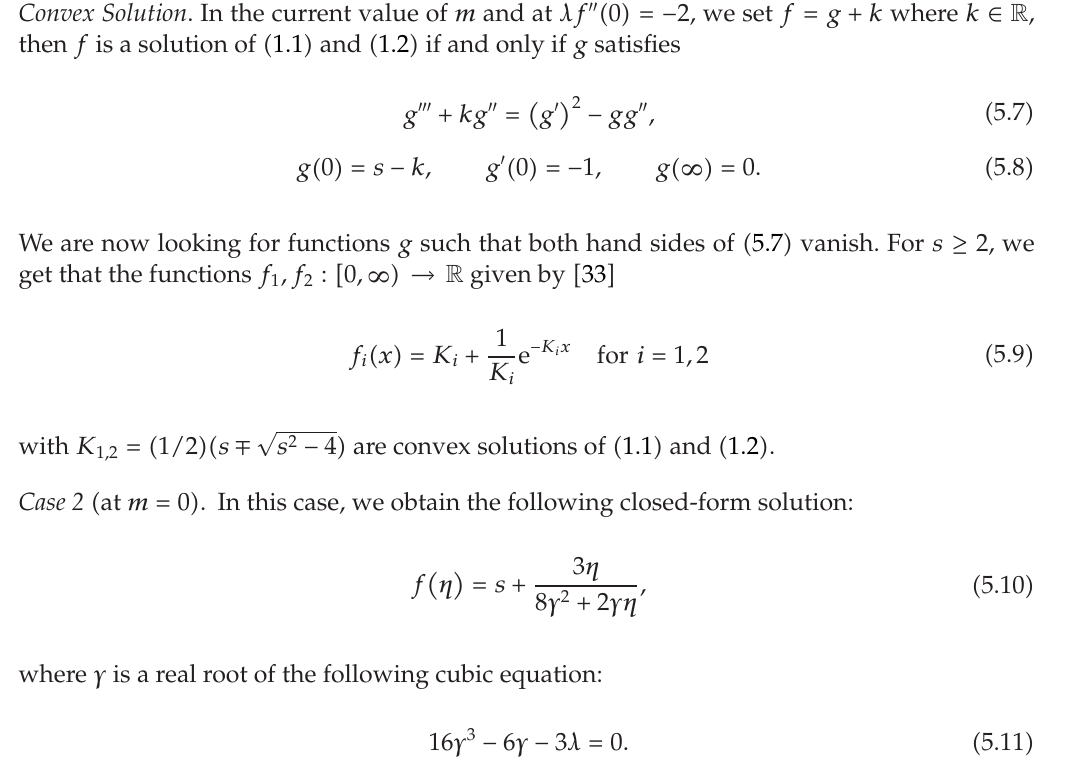
(cid:3) η, f (cid:3) η (cid:4)(cid:4) plane at m (cid:8) 1 for (cid:3) a (cid:4) s (cid:8) 1, λ (cid:8) 0 . 5 and (cid:3) b (cid:4) s (cid:8) 0, λ (cid:8) 1. It can be seen from this figure that the solutions are identical and matching with those results in (cid:5) 11 (cid:6) . Convex Solution . In the current value of m and at λf (cid:2)(cid:2) (cid:3) 0 (cid:4) (cid:8) − 2, we set f (cid:8) g (cid:7) k where k ∈ R ,